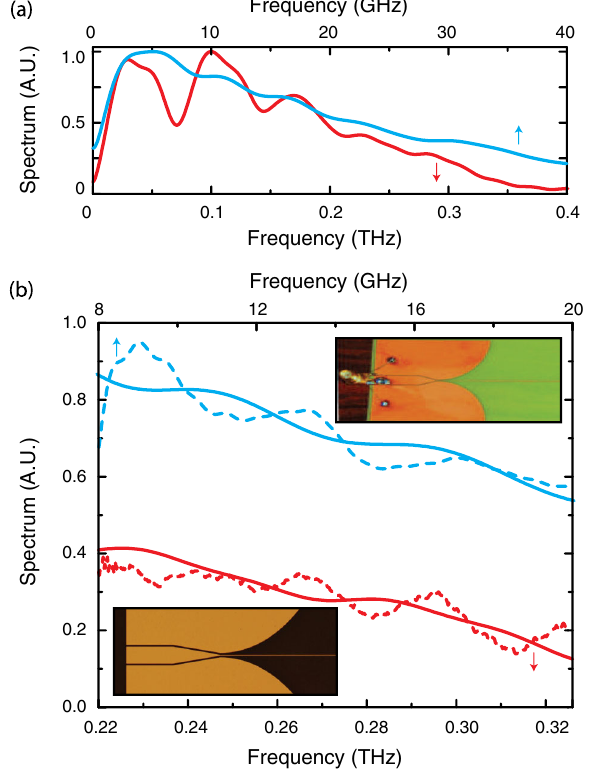
FIG. 2. (a) Simulated spectra of GHz (blue curve) and THz (red curve) PGL waveguides. (b) Experimental (dashed curves) and simulated (solid curves) spectra for both the GHz (blue) and THz (red) PGLs. Insets are optical images of the gigahertz (top right) and terahertz (bottom left) waveguides. The blue and red arrows in both panels indicate the x axes of the individual curves.